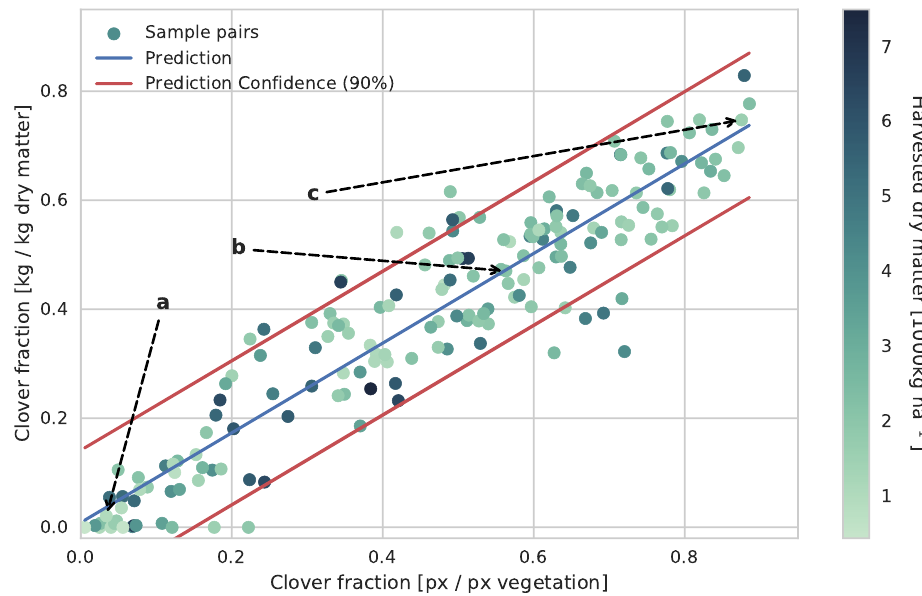
Figure 10. Comparison and linear regression of the visual clover ratio determined by the CNN and the actual clover ratio in the harvested dry matter at the primary field site. The linear relationship between the visual and dry matter fraction of clover in the sample pairs is clear. The annotations a , b , and c refer to the three image samples shown in Figure